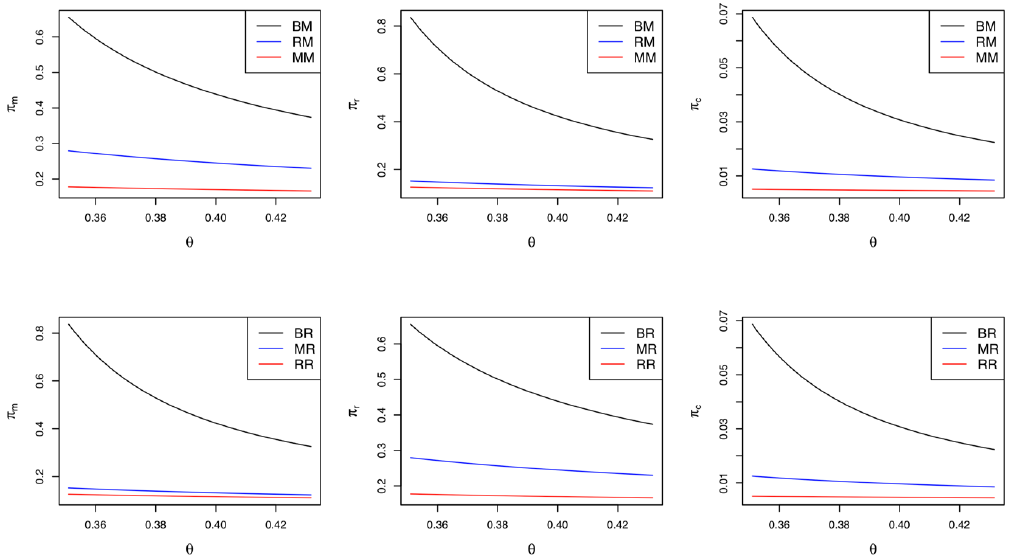
Figure 6. Comparisons of profits in the closed-loop supply chains (CLSC) led by the manufacturer and the retailer.